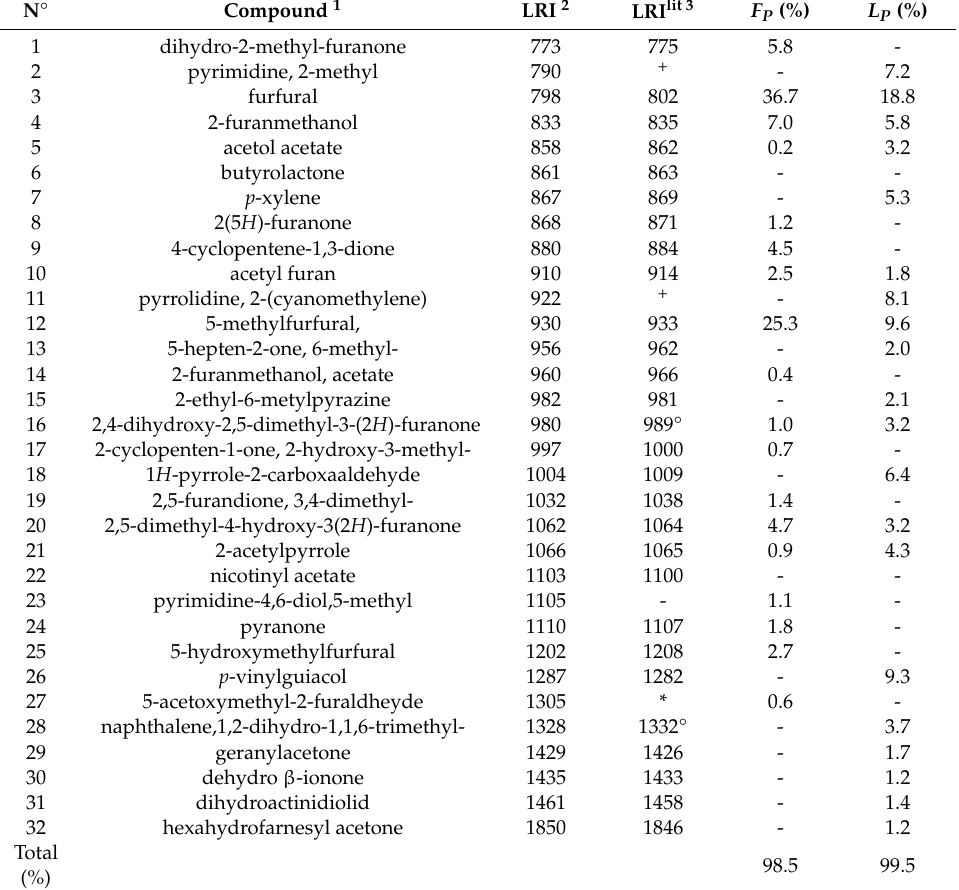
Table 3. Chemical composition (%) of vapor phase of dried leaves and fruits of Elaeagnus angustifolia . N